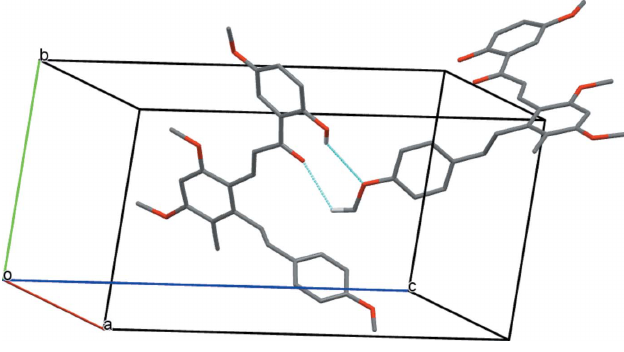
rings in (I). The C26 atom of the methoxy group at C2 is almost co-planar with the benzene ring [C3—C4—O4—C26 = 0.8 (3) (cid:3) ], whereas atoms C25, C27 and C28 of the methoxy groups at C2, C14 and C21, respectively, are slightly twisted from the corresponding ring planes [C3—C2—O3—C25 =